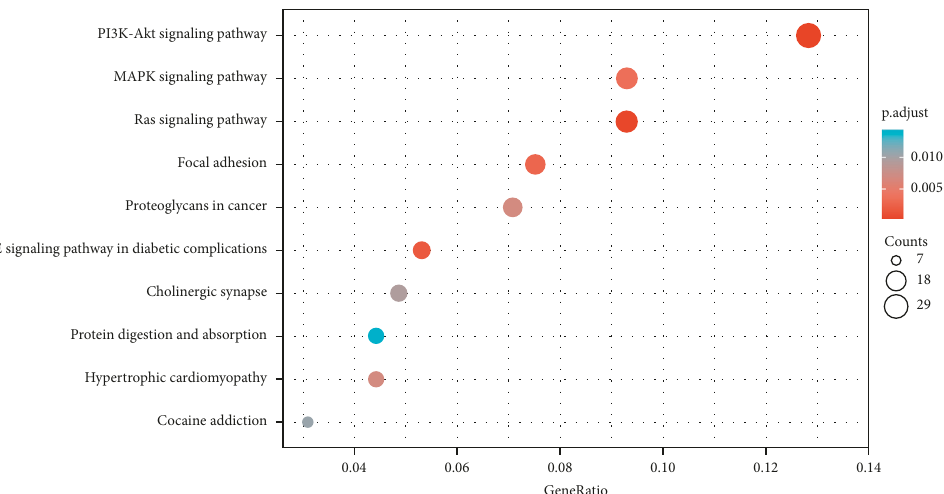
Figure 8: KEGG analysis of miR-149-3p target